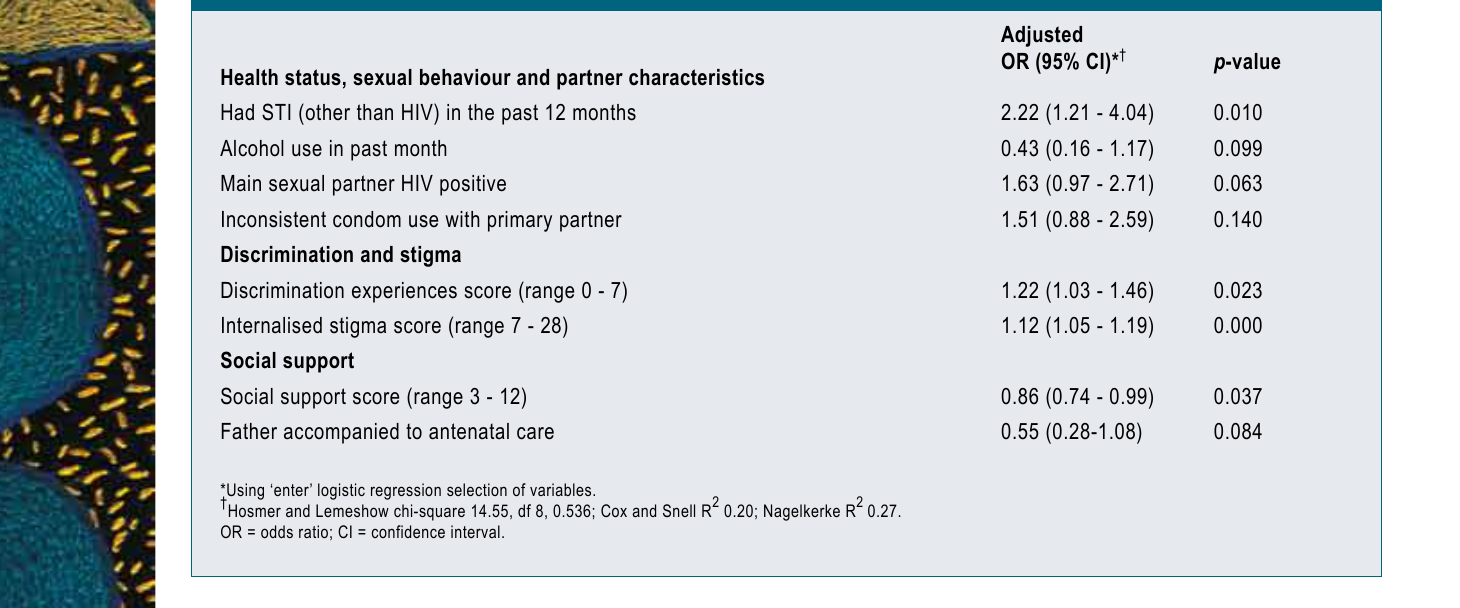
tABle ii. logiStiC RegReSSion AnAlySiS: pRediCtoRS of depReSSed Mood (